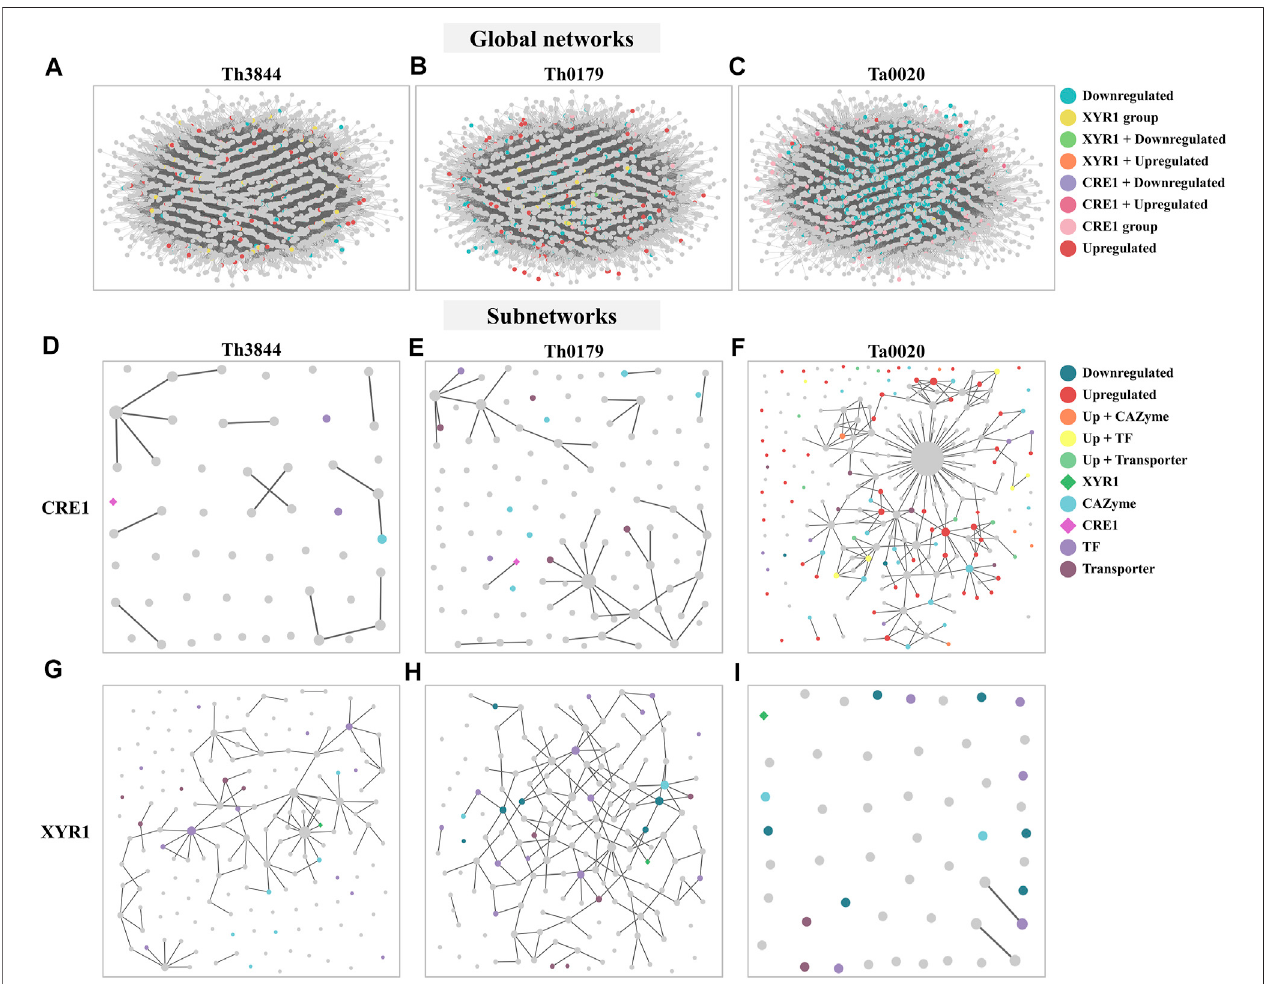
FIGURE 6 | Modeled global networks and modeled subnetworks of the cre1 and xyr1 groups of the evaluated strains. The transcriptome datasets were used to infertheglobalHRRnetworksof (A) Th3844, (B) Th0179,and (C) Ta0020.ThenetworksweremodeledandeditedusingCytoscapesoftware.Theglobalnetworkswere partitioned, and subnetworks of Th3844 (D) , Th0179 (E) and Ta0020 (F) related to cre1 were constructed, as well asTh3844 (G) , Th0179 (H) and Ta0020 (I) related to xyr1 . Each color represents a category of transcripts identi fi ed in the global networks and subnetworks. Th3844: T. harzianum IOC-3844; Th0179: T. harzianum CBMAI-0179; Ta0020: T. atroviride CBMAI-0020; TF: transcription